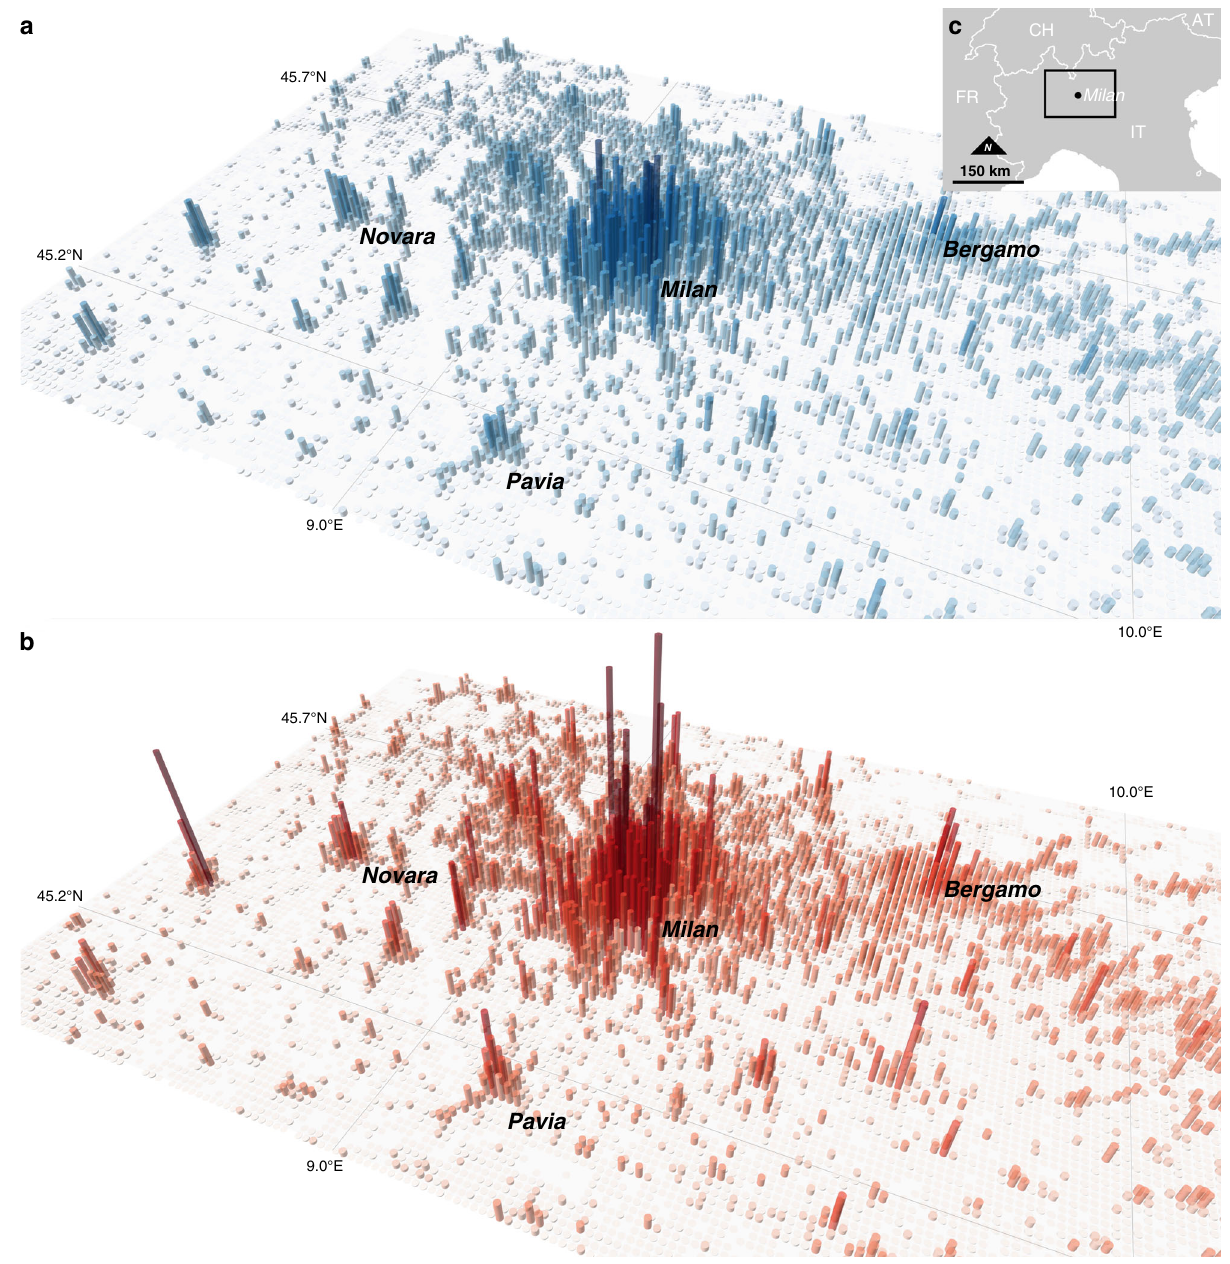
Fig. 1 Bird ’ s-eye view of population density in the area of Milan. Population density based on the average of all months at nighttime ( a ) and daytime ( b ). These representations cover an approximate swath of 150 km (East – West) by 100 km (North – South), and each vertical bar corresponds to a 1 × 1 km grid cell. The height of bars is linear function of the estimated population. The highest bar at nighttime ( a ) records 23.3k persons and the highest bar at daytime ( b ) records 42.9k persons. c The geographical location and extent of the represented area. The fi gure can be reproduced using the publicly deposited multi- temporal population grids 75 . Copyright EuroGeographics for the administrative